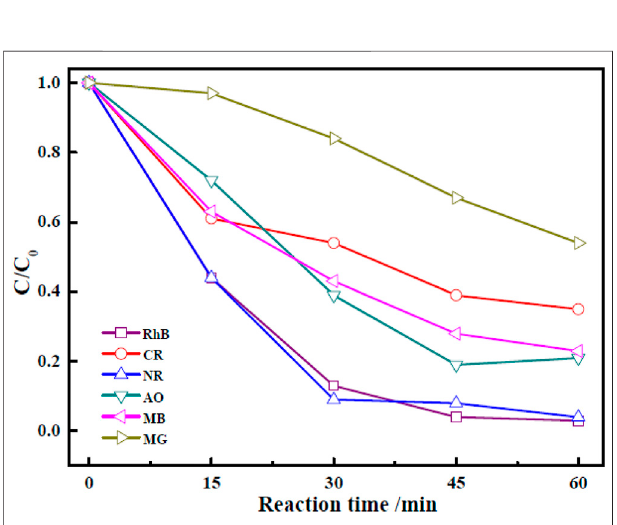
FIGURE 10 | Photocatalytic degradation curves of different dyes over Zn-Zr